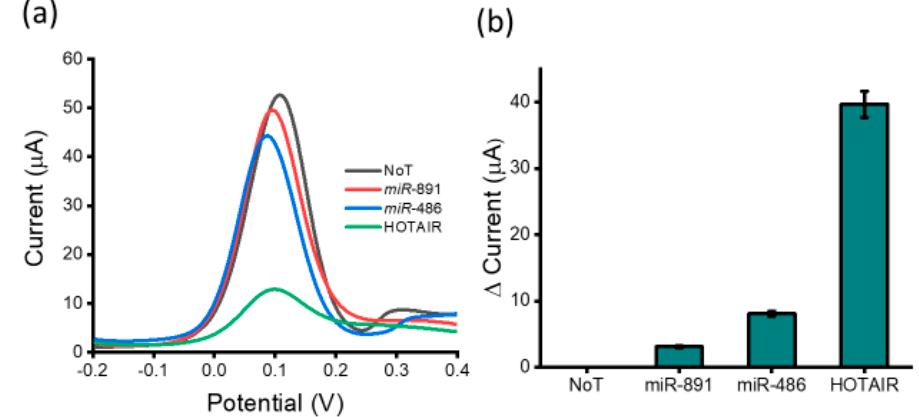
Figure 4. Assay specificity: ( a ) DPV readout displaying current output after the assay was tested with various miRNA sequences (miR-891 and miR-486 (100 nM), NoT and target HOTAIR lncRNA (100 nM)) and ( b ) relative current change of miRNA sequences and target HOTAIR lncRNA with respect to the NoT. Error bars represent the standard deviation across three separate experiments.